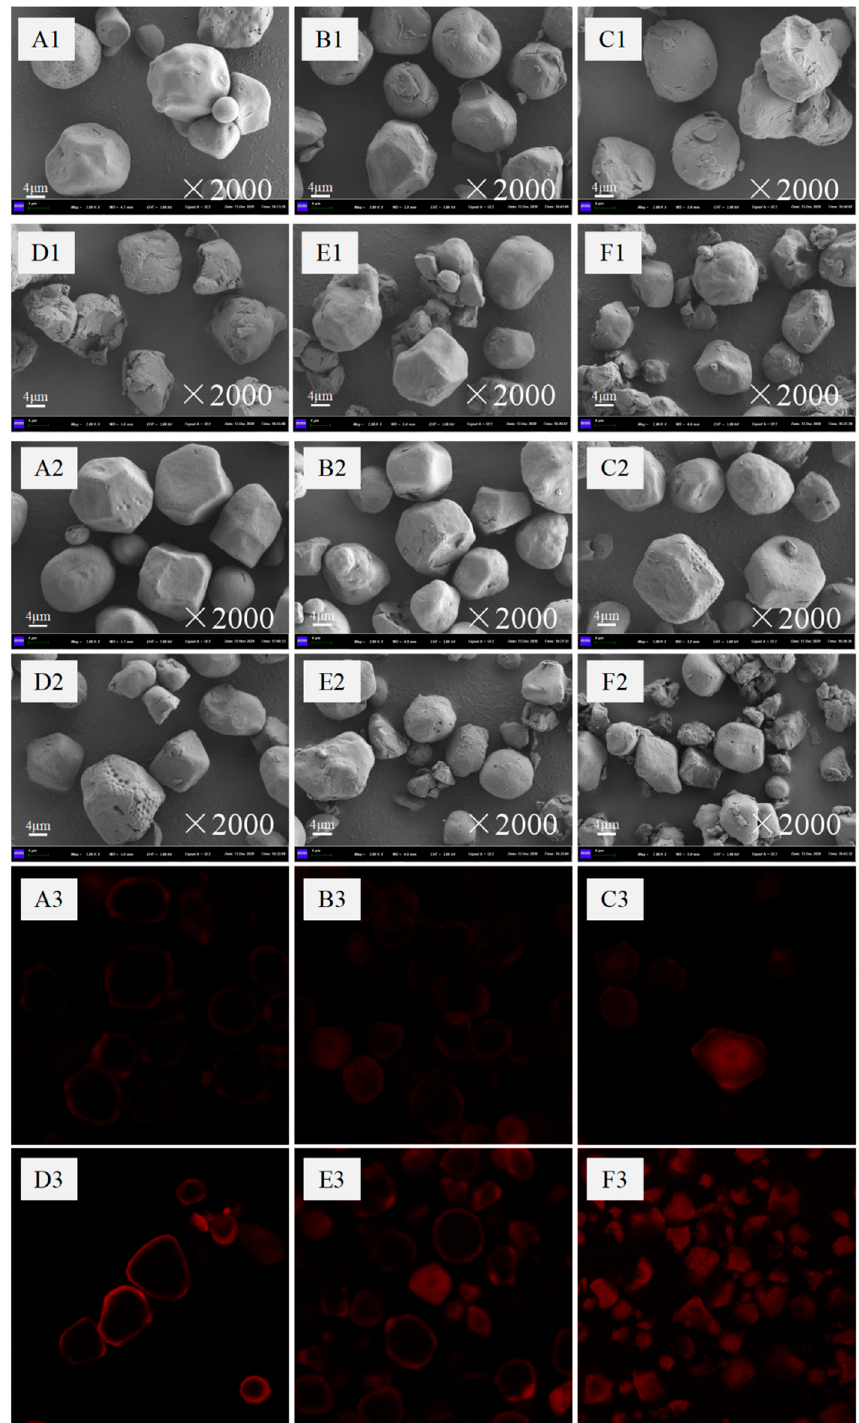
Figure 1. SEM and CLSM of the native and treated corn starch samples: A1 – F1 are the SEM images of native starch and J1 – J5 starch, respectively; A2 – F2 are the SEM images of OSA-starch and J1 – J5 OSA-starch, respectively; A3 – F3 are OSA-starch and J1 – J5 OSA-starch, respectively CLSM